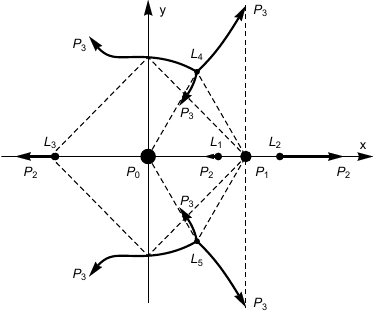
Figure 7. Triangular equilibrium configurations for three possible positions of particle P 2 , µ 1 = 0 . 1, 0 ≤ µ 2 ≤